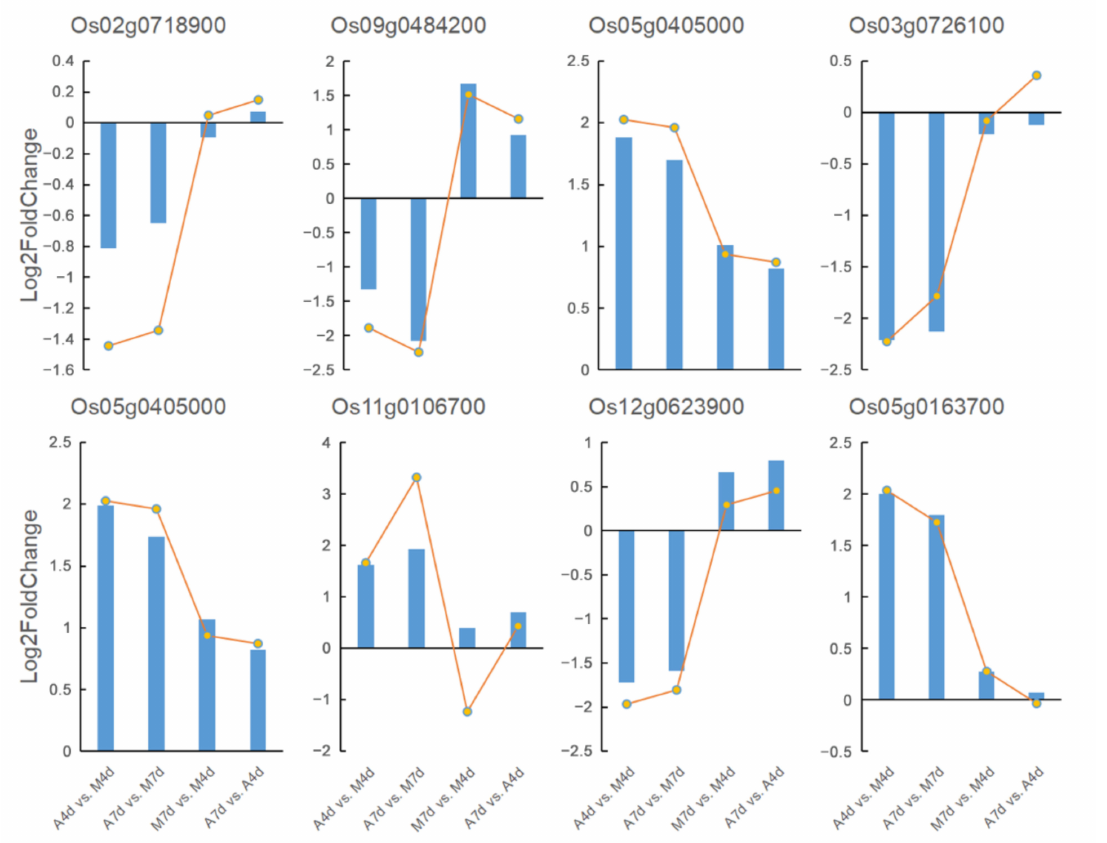
Figure 8. Comparison of RNA-seq results and qRT-PCR analysis of gene expression levels. Log2FoldChange of 12 genes among M4d, M7d, A4d and